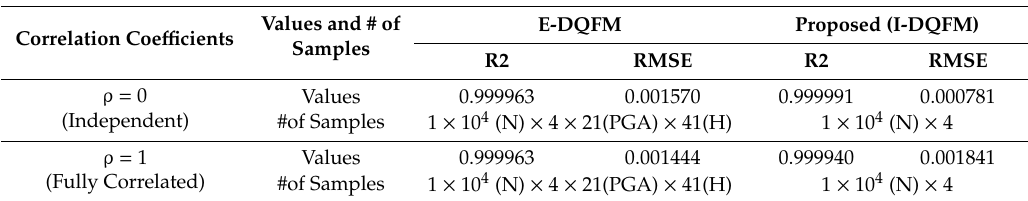
Figure 9. Comparison of multi-hazard system fragility results regarding the example (C1 ∪ C2) ∩ C3 ((2) fully dependent condition)): ( a ) Boolean; ( b ) E-DQFM; ( c ) proposed (I-DQFM). Table 3. Comparison of the results of R 2 and RMSE of a multi-hazard system fragility curve obtained from the E-DQFM and the proposed method, for example, “(C1 ∪ C2) ∩ C3”.